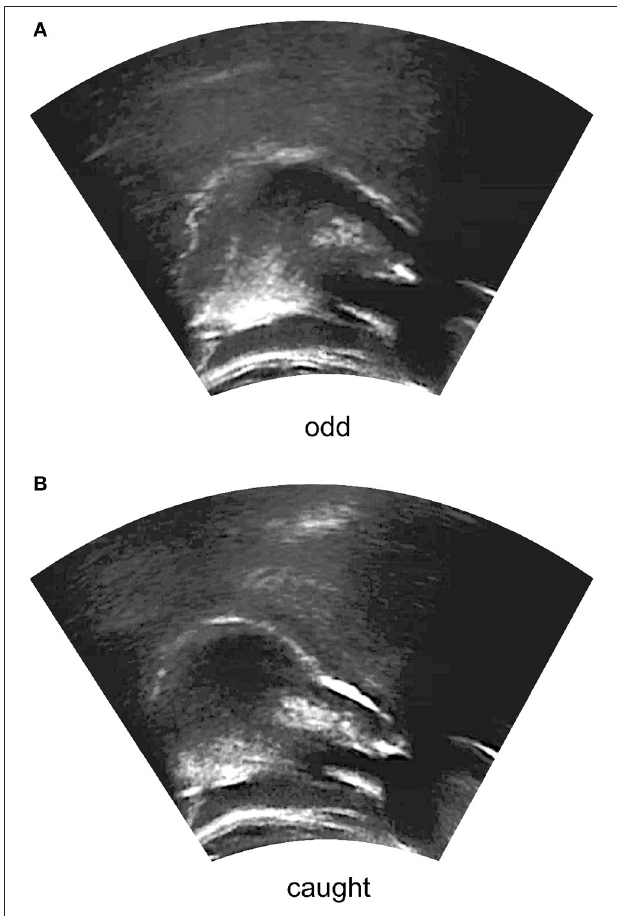
FIGURE 2 | Extracted midsagittal ultrasound frames for the tokens (A) odd and (B) caught, as produced by Speaker 6. The right side of the image corresponds to the front of the mouth. The tongue surface is visible as the white line near the center of the image. The dark portions on the left and right sides of the image are the shadows of the hyoid and the